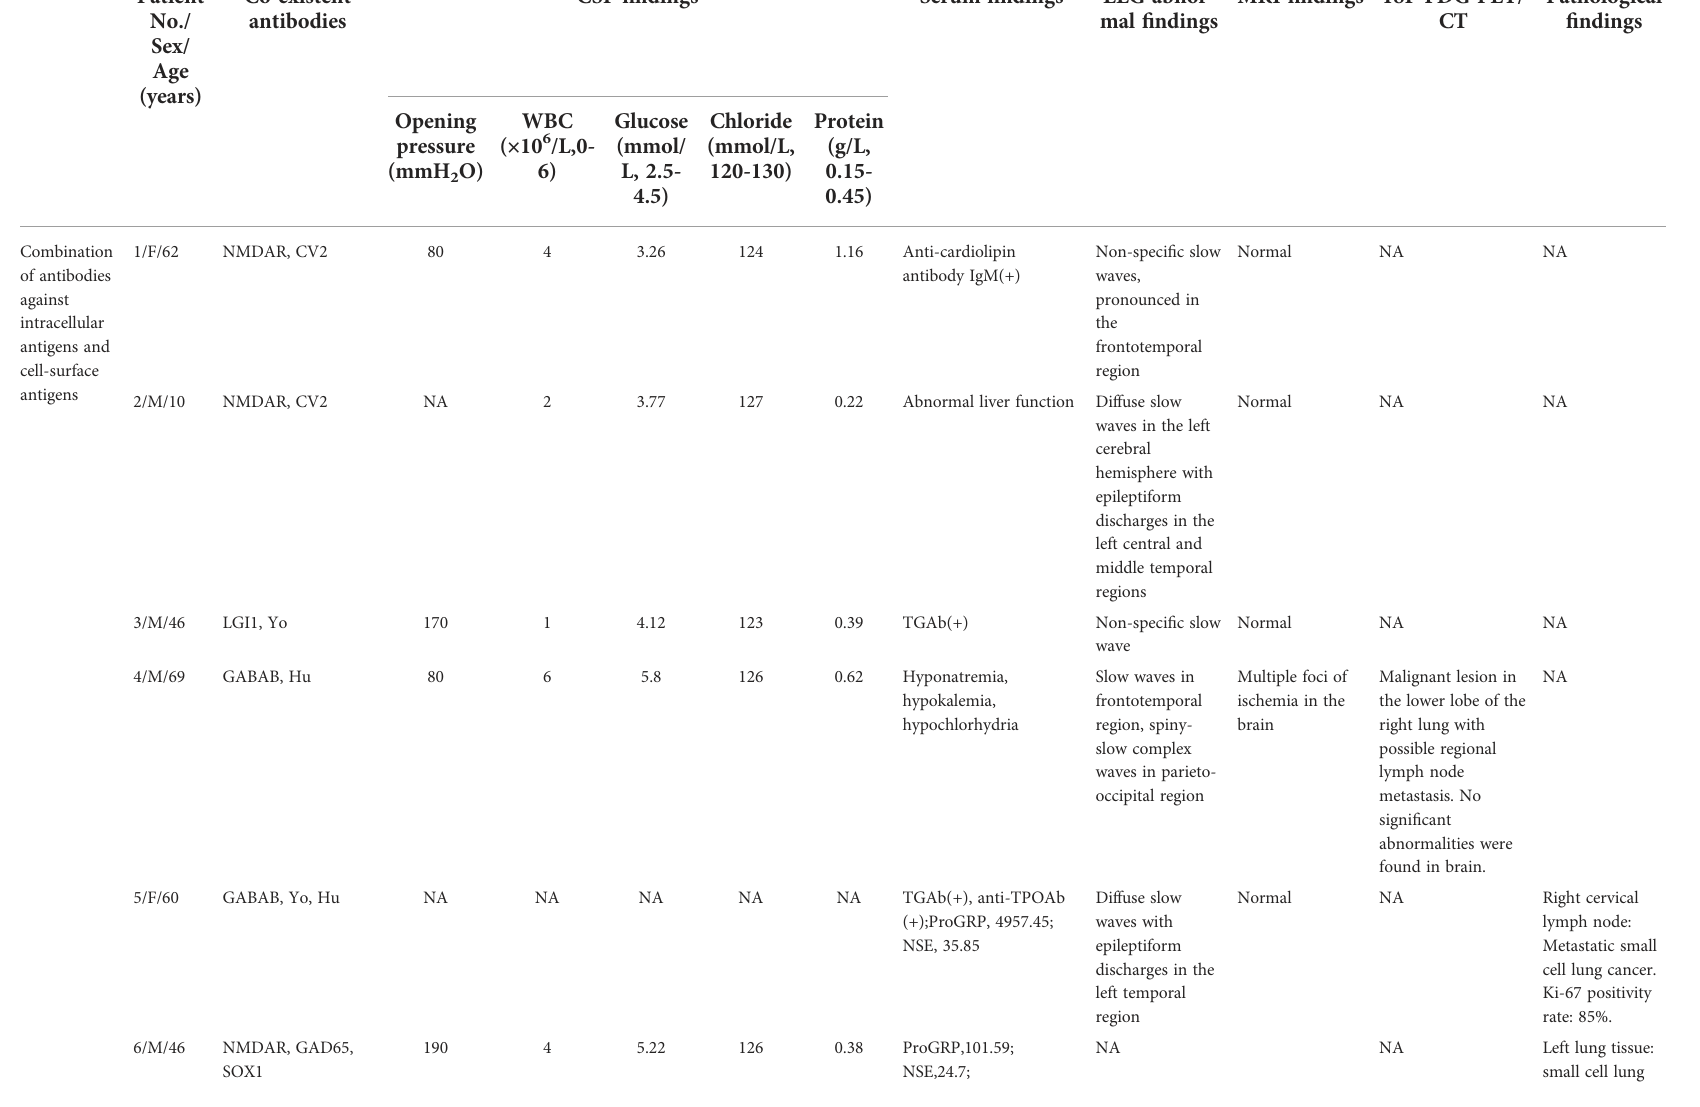
TABLE 2 Auxiliary fi ndings of patients with co-existence of multiple anti-neuronal antibodies. Patient